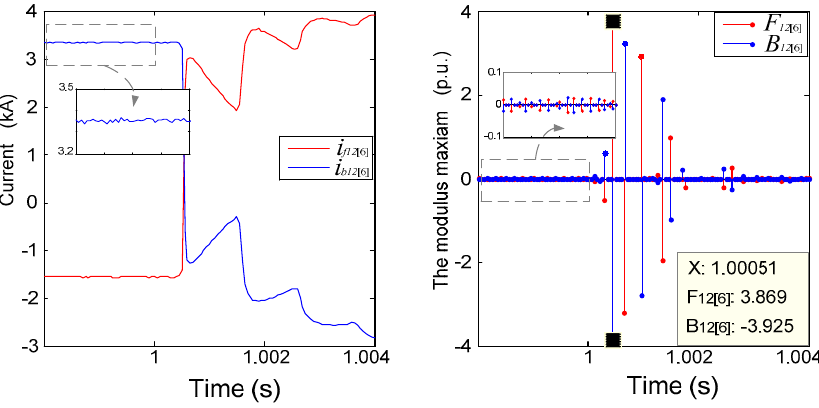
Figure 13. Simulation results of for f 1 fault with 40 dB Gaussian noises added.